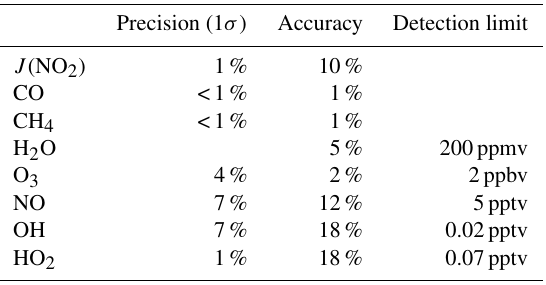
Table 1. Precision, accuracy and detection limit of the in situ mea- surements used to deduce